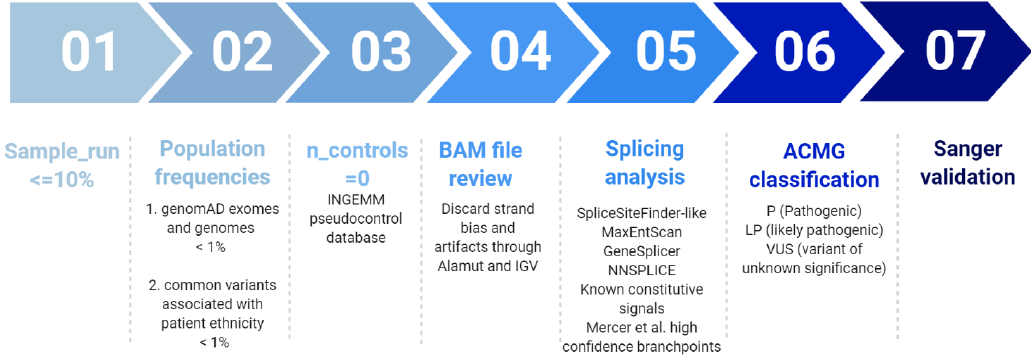
Figure 1. Filtering pipeline for NGS panel HAP v1.2. Modified from Tenorio et al. 2020 [25]